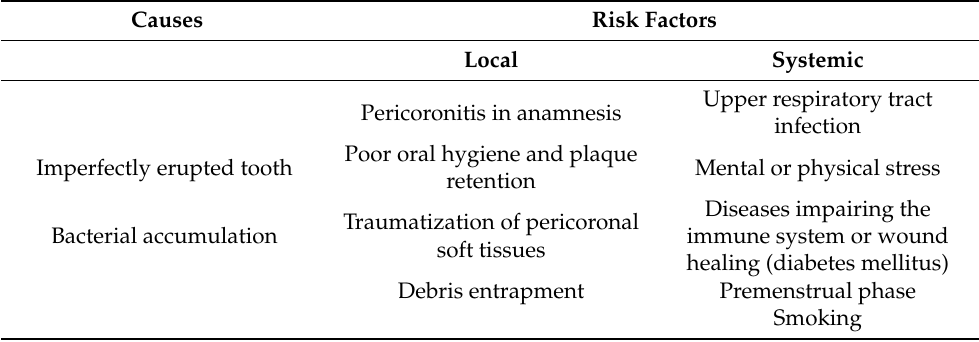
Table 2. Causes and risk factors for